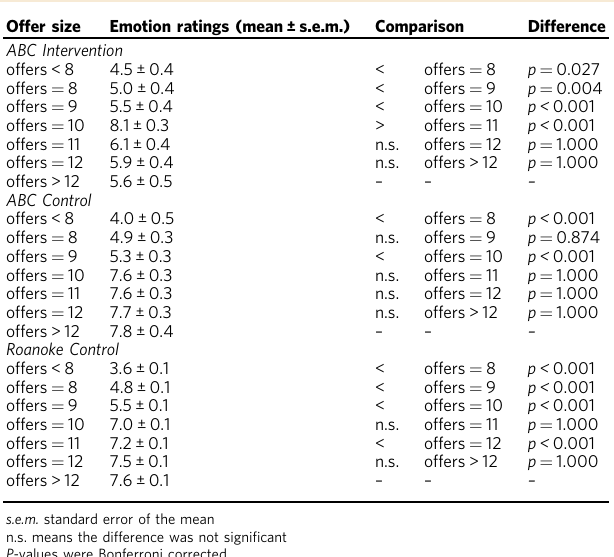
Table 3 Emotion ratings between offer sizes in Medium- High-Medium conditioning